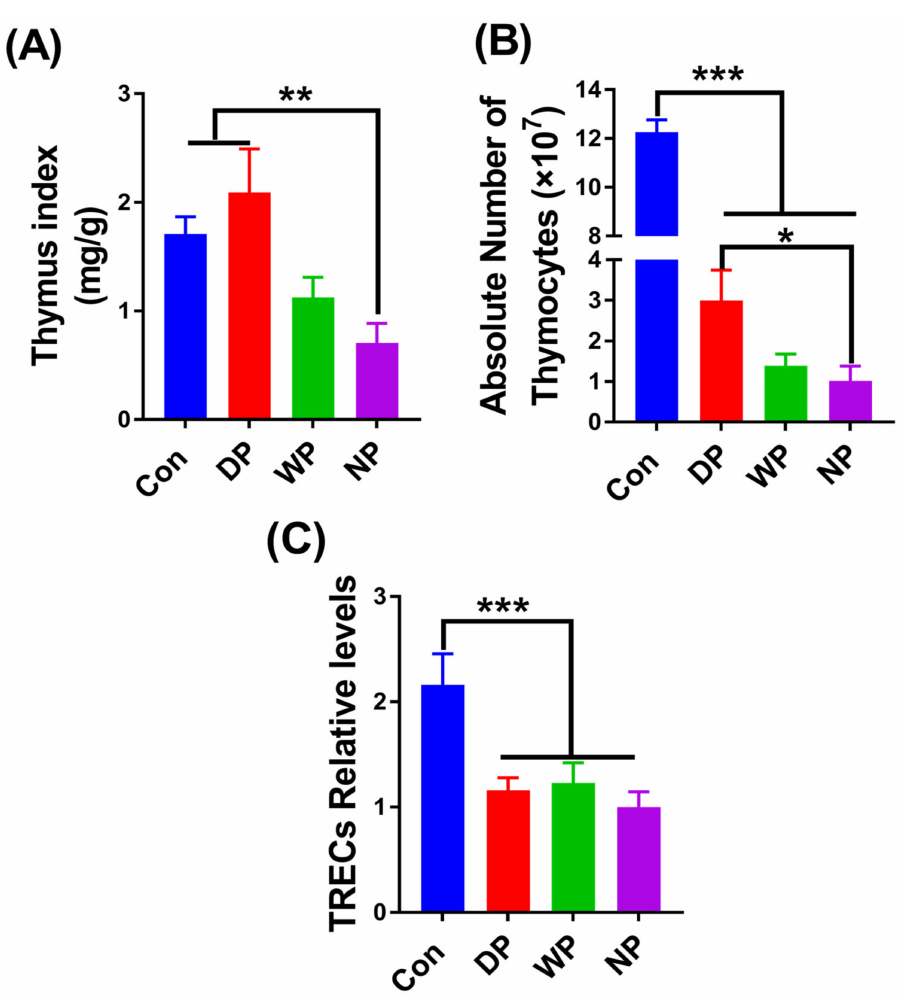
Figure 4. Thymus index, thymocyte count, and thymic recent output function were analyzed on day 28 post-BMT. Mice were euthanized before removal of the thymus for measuring thymus index ( A ); a single-cell suspension was obtained to measure the number of thymocytes ( B ); DNA was extracted from whole blood using a genomic DNA extraction kit (TIANMO, China). A relative quantitative method was used to evaluate the expression level of TRECs on day 28 after BMT ( C ). Data are presented as mean ± SEM ( n = 5–7). Results are representative of at least two independent experiments. *** p < 0.001, ** p < 0.01, * p <